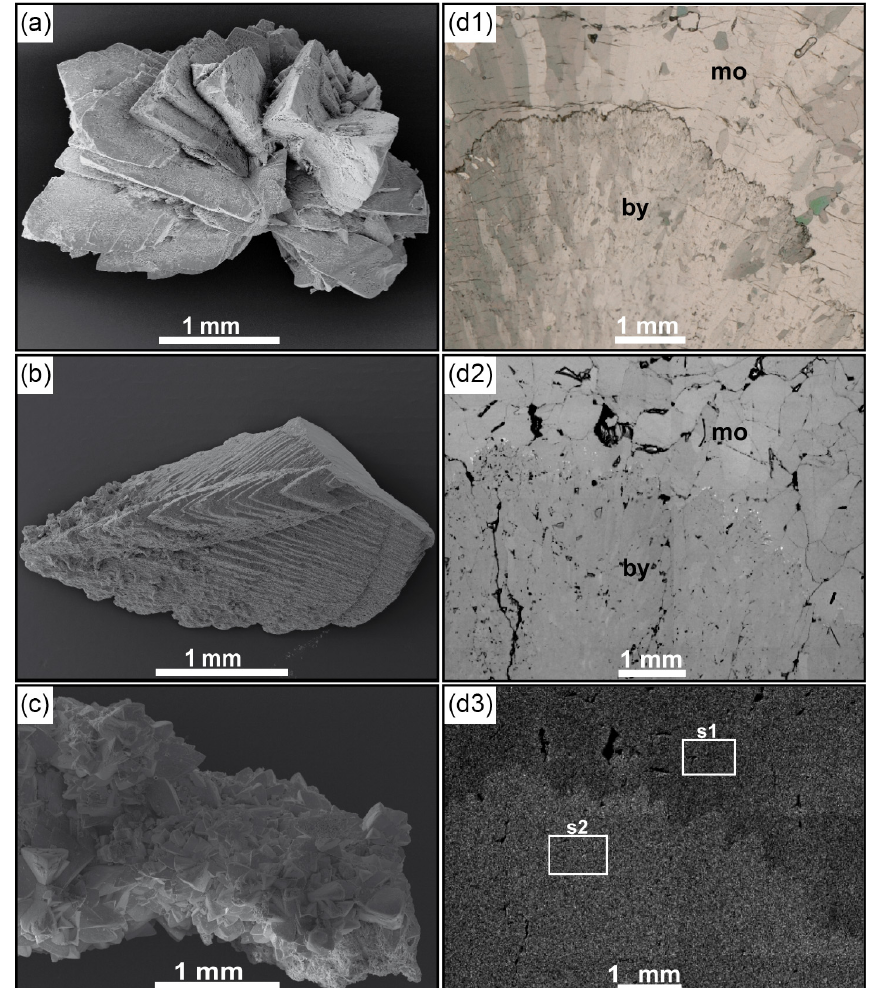
Figure 5. Petrographic characteristics of Hells Bells speleothems. SEM images of Hells Bells samples Z17-8DC (a) , Z17-18J (b) and Z17- 9J (c) of El Zapote cenote showing bladed (a) , dogtooth-like (b) and blocky calcite rhombs (c) . Polarized transmitted light-microscopic images of a thin section from ZPT-7 (d1) (shown in Stinnesbeck et al., 2017b) showing different calcite fabrics of angular coarse-grained mosaic calcite (mo) and fine-grained elongated botryoidal calcite (by). The same detail is shown in the BSE image of the polished counter slab that corresponds to the thin section (d2) . The Mg element map (d3) , where higher abundances of Mg appear brighter, indicates a difference in Mg content between the botryoidal and mosaic calcite phases. The white rectangles represent areas of measured integrated element